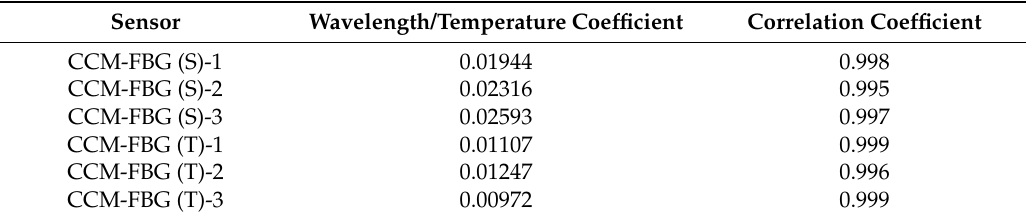
Table 2. Simple linear regression model of the wavelength/temperature coefficient. Sensor